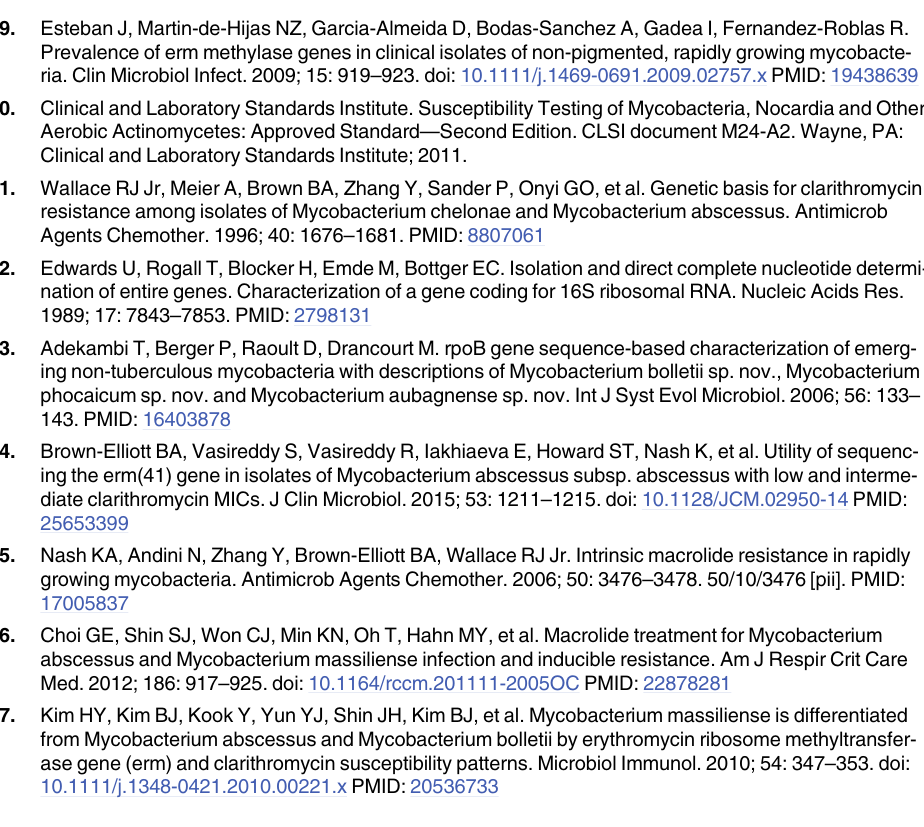
PLOS ONE | DOI:10.1371/journal.pone.0158723 August 4,